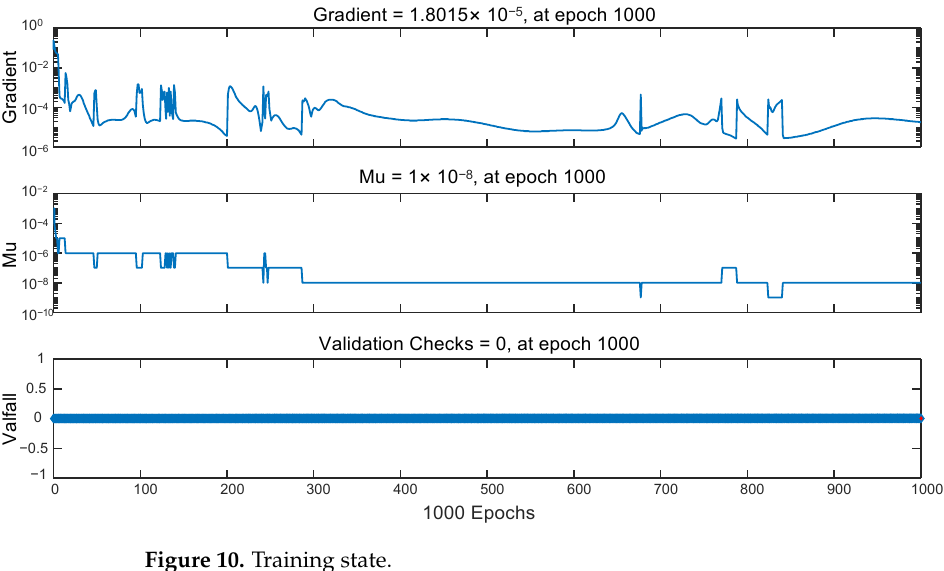
Figure 10. Training state.